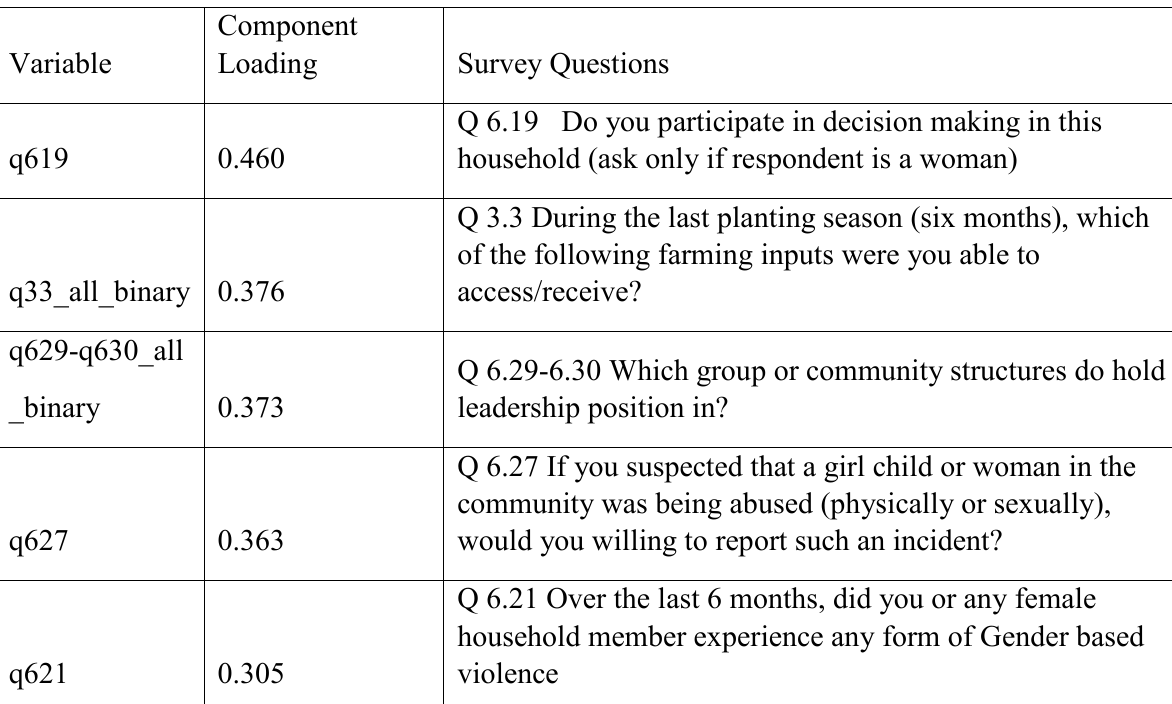
Table 1.56: Variables defining Transformative Resilience PC9